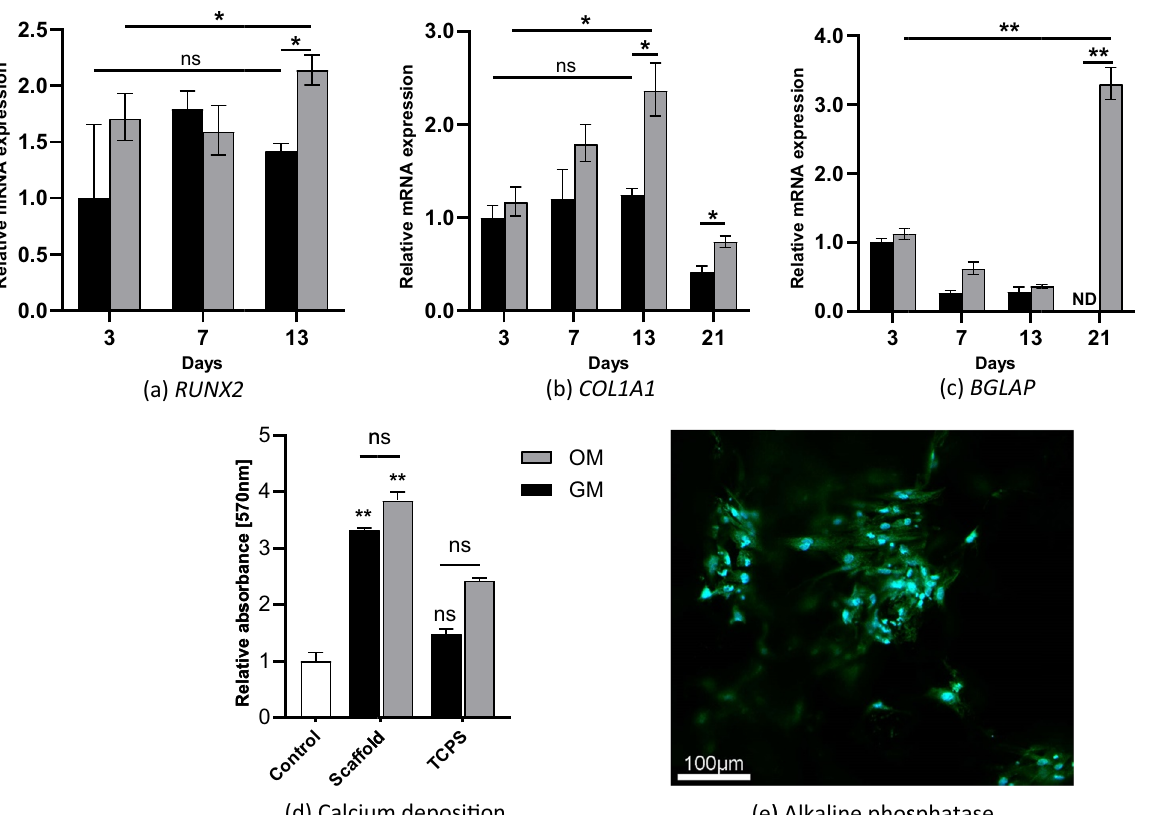
Fig. 5 Osteogenic differentiation. mRNA expression of ( a ) RUNX2 , ( b ) COL1A1 , and ( c ) BGLAP . The results are presented relative to gene expression at day 3 for cells cultured in GM ( n = 3), ND not detected. d Absorbance measurements after staining for calcium depositions at 28 days. The control sample is a cell-free control and TCPS stands